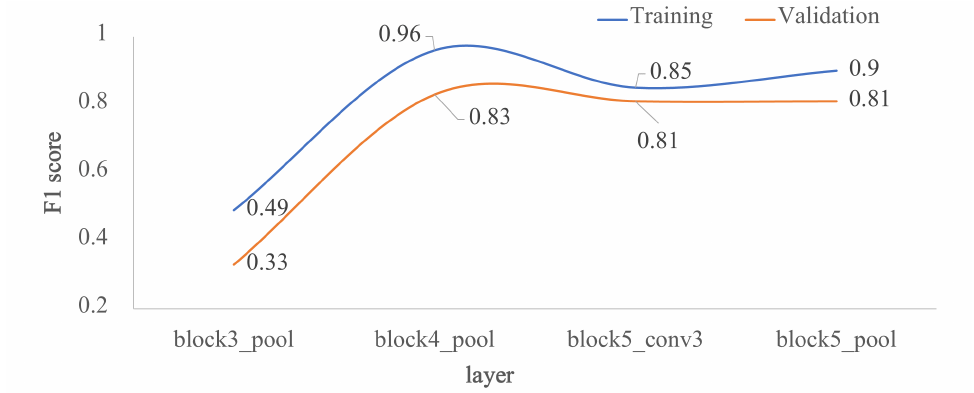
Figure 6. Impact of the depth for the architecture by transfer learning using VGG-16, in terms of F1 score: training vs. validation. The x -axis corresponds to the selected last layer of VGG-16, and the y -axis is the F1